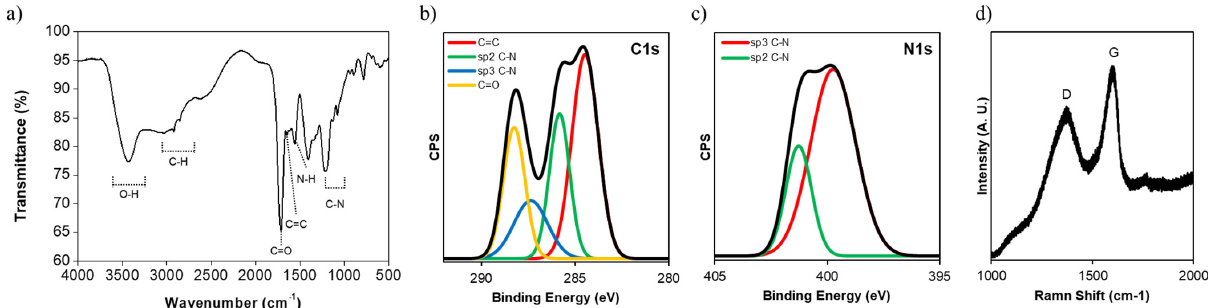
Figure 2. ( a ) FT-IR spectrum, ( b , c ) XPS spectra (C1s, N1s), and ( d ) Raman spectrum of NGQDs. NGQDs show UV-Vis absorption peaks at 250 and 350 nm, which corresponded to the π – π * transition of aromatic sp2 C=C and the n– π * transition of carbonyl C=O [62], respectively, which means that NGQDs are composed of aromatic sp2 C=C domains and 432 nm) at 365 nm excitation (Figure 3b,c). From the overall characterization data, we